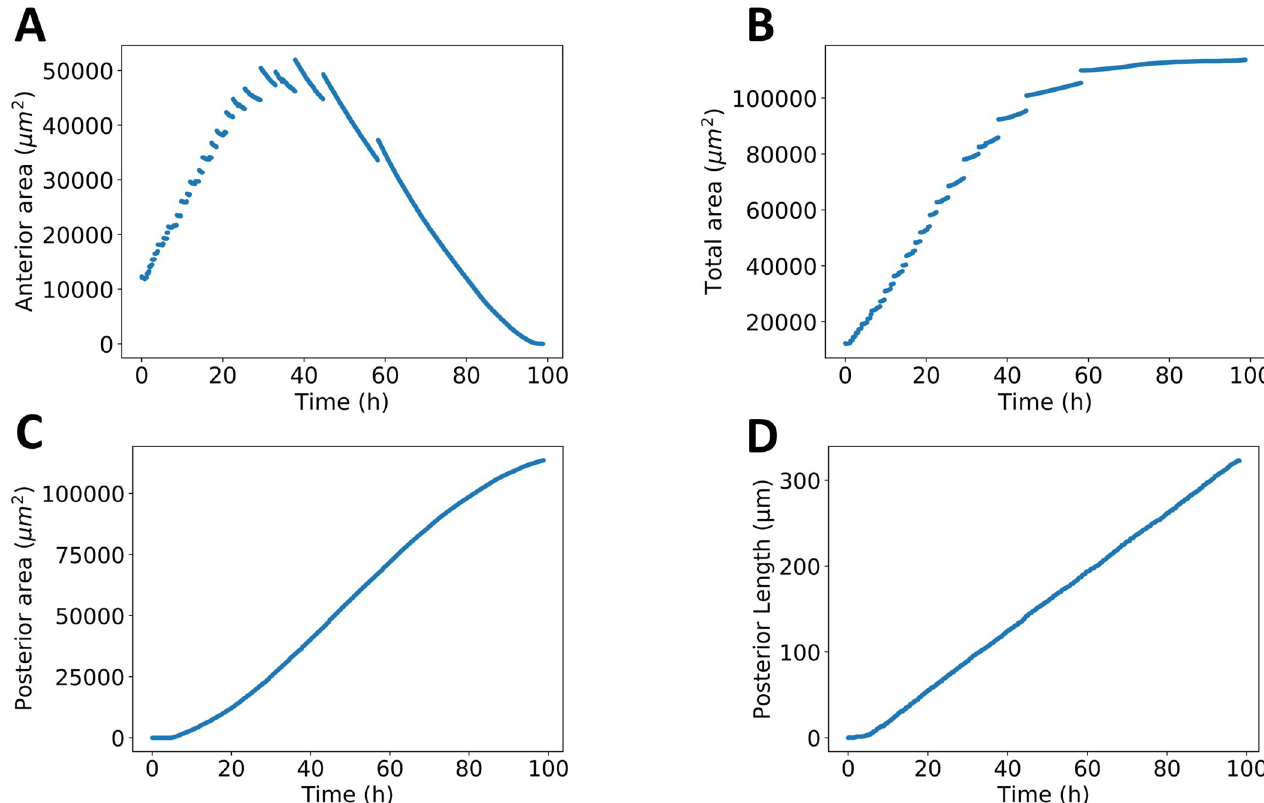
Fig 8. Drosophila eye disc growth dynamics. A: Time dependence of anterior area, defined as the portion of the tissue ahead of the MF. Cell division takes place only on the anterior portion of the eye disc. B: Time dependence of total area. The final value is in the same order of magnitude found in wild-type Drosophila strains. C: Time dependence of posterior area, defined as the portion of the tissue before the MF. Cell division is arrested in the posterior portion of the tissue. The posterior grows solely by cells exiting the propagating MF. D: Time dependence of the posterior length, defined as the distance of the posterior edge to the midpoint of the MF. Aside from initialization time, the posterior length increases linearly, with a slope of 3.4 μm / hr , in accordance with MF propagation experimental data.